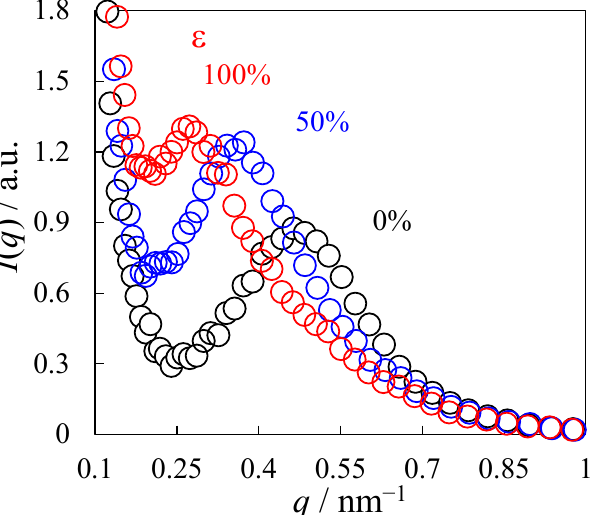
Figure 8. SAXS profiles of the heat-elongated TPU film ( λ = 300%) during uniaxial stretching at various strains ε at 23 °C.